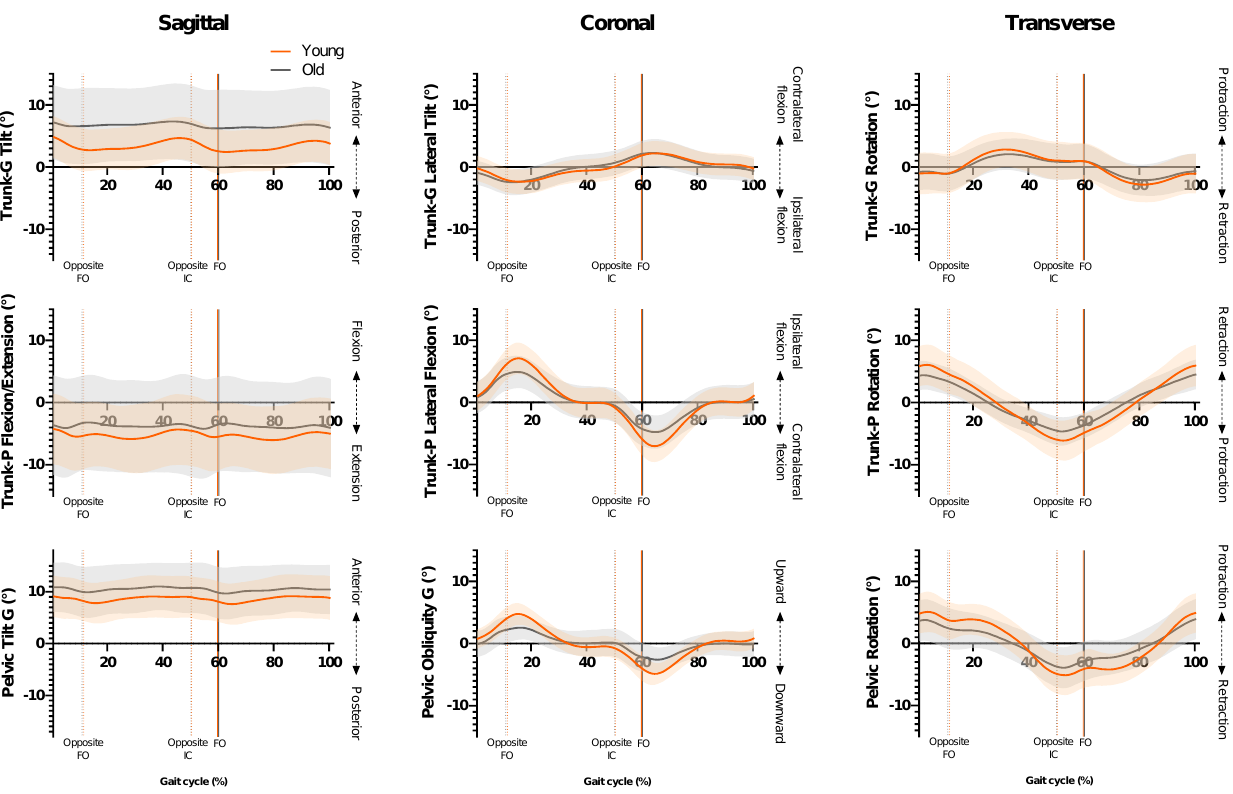
Figure 1. Ensemble averages for trunk-G (trunk relative to global reference frame), trunk-P (trunk relative to pelvic reference frame) and pelvis kinematics. Orange line = YG mean, grey line = OG mean, orange shaded area = YG SD, grey shaded area = OG SD. FO = Foot-off, IC = Initial contact. No significant phase-specific differences were revealed for pelvic tilt between age groups. Two clusters for pelvic obliquity (Figure 4) at 10.3–24.6% and 59.4–73.8% exceeded the critical threshold indicating that pelvic obliquity in the YG was significantly greater during midstance and initial swing than in the OG ( t (22) = 3.274, p = 0.003; t (22) = 3.247, p = 0.002, respectively). One supra-threshold cluster (67.8–76.3%) exceeded the critical threshold of t (22) = 3.222 for pelvic axial rotation, as the YG exhibited significantly greater pelvic rotation than the OG during swing phase ( p = 0.023) (Figure